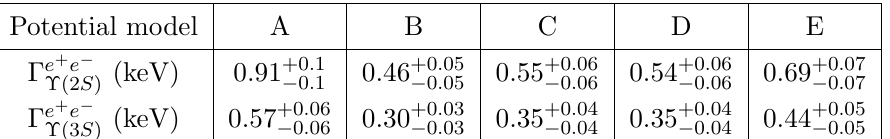
Table 10 . Results for the leptonic decay widths of the states (cid:7)(2 S ) and (cid:7)(3 S ), indicated with (cid:0) e + e (cid:0) and (cid:0) e + e (cid:0) for short. Wavefunctions at the origin and binding energies have been computed (cid:7)(2 S ) (cid:7)(3 S ) within the potential models of section